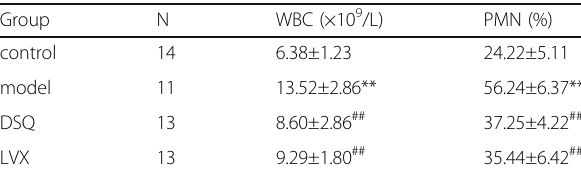
Table 3 WBC population and PMN percent in peripheral blood in each group (mean ±